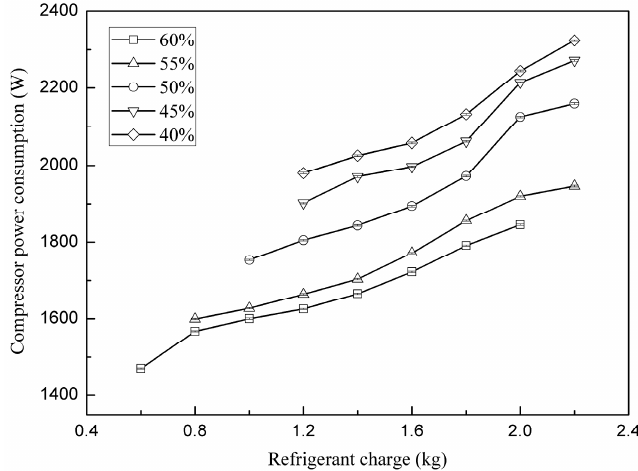
Figure 9. Variations of compressor power consumption with refrigerant charge and EEV opening.